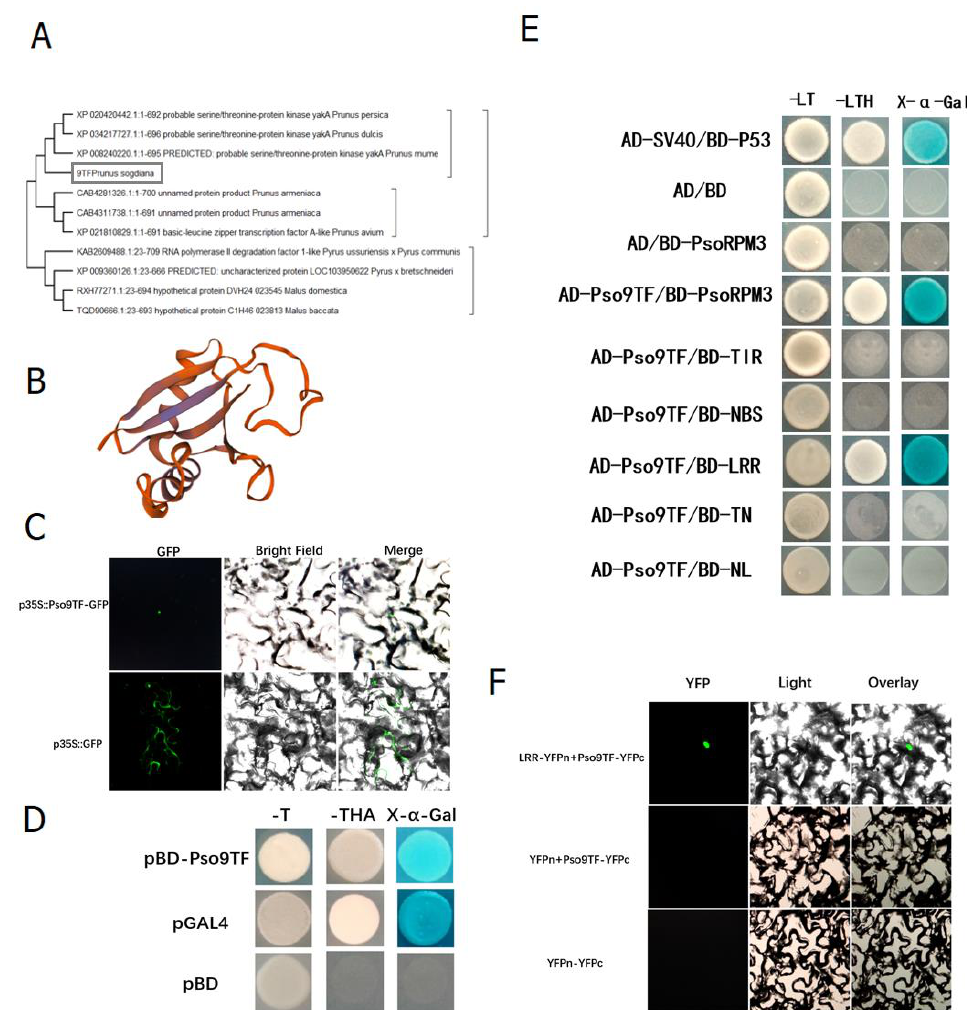
Figure 3. Basic characteristics of Pso9TF and detection of interactions with PsoRPM3 . ( A ) Phylogenetic tree containing Pso9TF (rectangle highlighted) and homologous proteins from other related plant species. ( B ) The predicted three-dimensional structures of the Pso9TF . ( C ) Pso9TF-GFP localized in the nucleus of N. benthamiana cells, GFP alone localized throughout the whole cells. Fluorescence (left), bright field (middle), and merged images (right) were obtained at 48 h post-agroinfiltration by using Leica confocal microscopy. ( D ) Transcriptional self-activation of Pso9TF using a yeast one-hybrid. ( E ) Interaction of Pso9TF with each structural domain of PsoRPM3 using yeast two-hybrid. ( F ) Interactions between PsoRPM3 and its three chaperonin proteins were determined by BiFC. YFP fluorescence in the upper epidermis cells of N. benthamiana leaves was detected by laser scanning confocal microscopy.